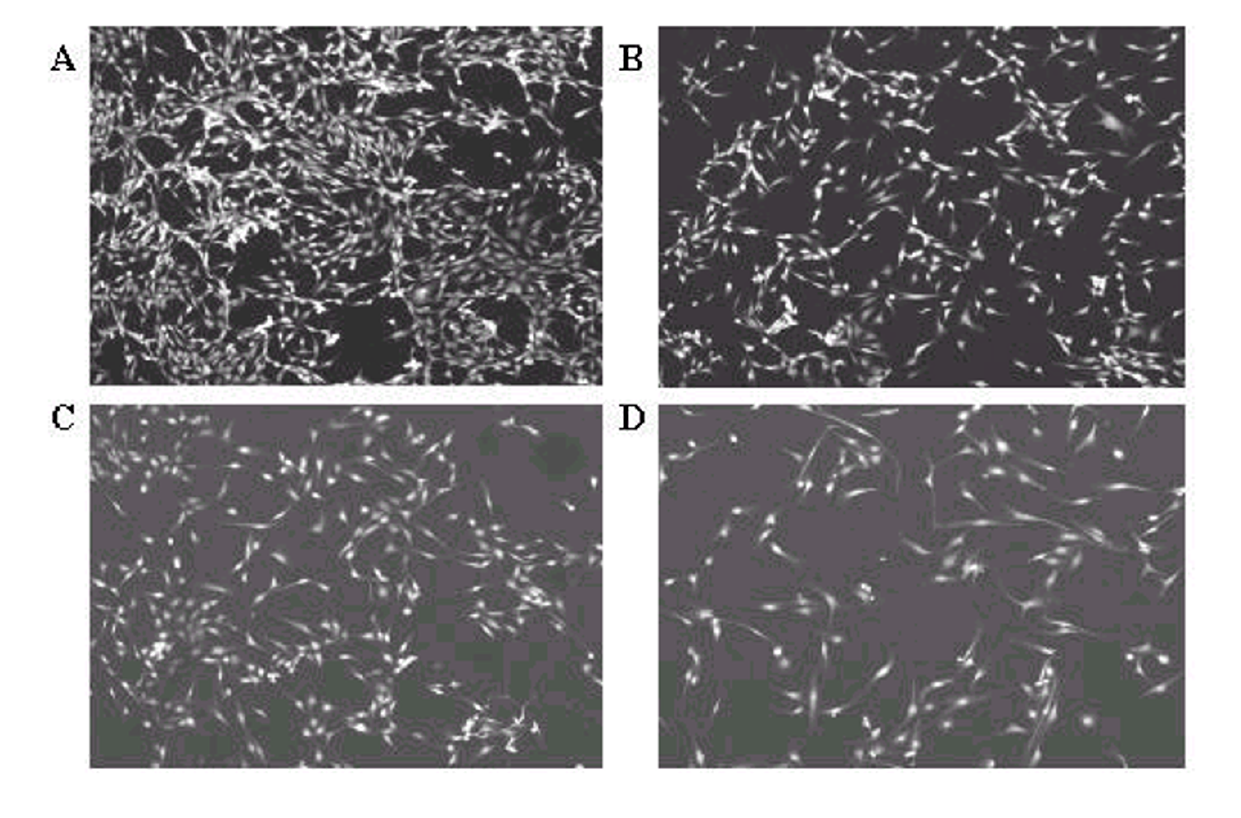
Figure 2 Morphology of passage 6 BPAEC treated with the following concentrations of resveratrol: A) 0 µ M; B) 10 µ M; C) 25 µ M; D) 50 µ M. Cells were stained with rhodamine-phalloidin and viewed under 10X confocal microscopy. The same experiment was repeated three times, using passages 6-7 cells from two different preparation of